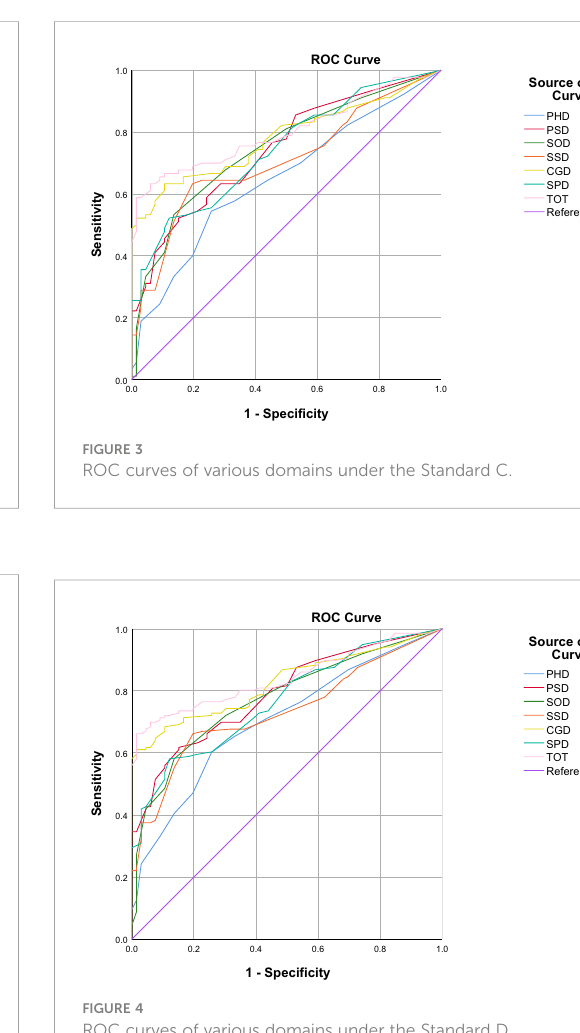
FIGURE 2 ROC curves of various domains under the Standard B.